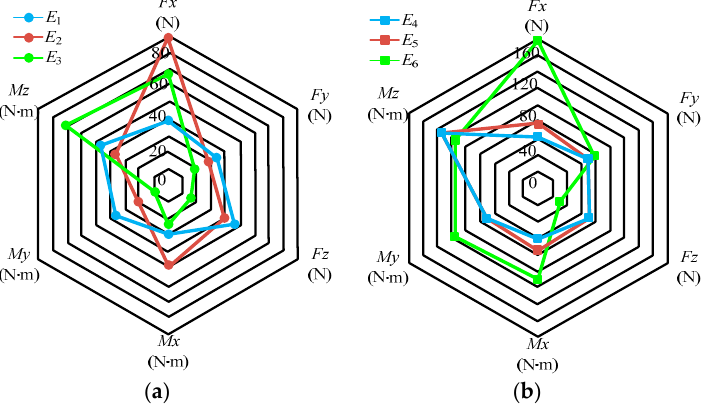
Figure 12. Error values in different directions of the sensor; ( a ) error output in loading directions of F x , F y , and F z ; ( b ) error output in loading directions of M x , M y , and M z .